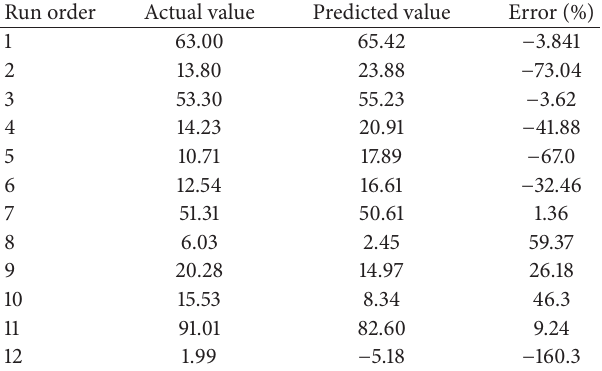
Table 8: Actual and predicted values for RBBR dye